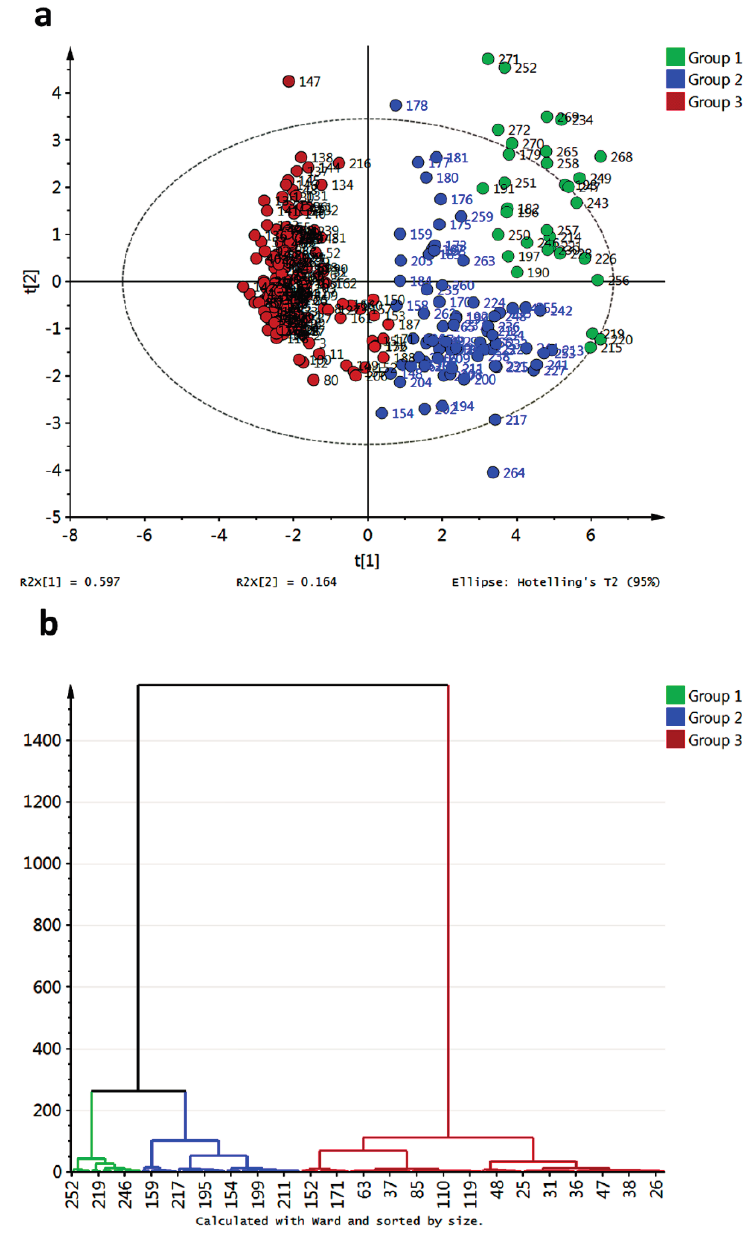
Figure 13. Unsupervised multivariate analyses from affinity values for docking of xanthones with target enzymes. ( a ) PCA score plot; ( b ) HCA